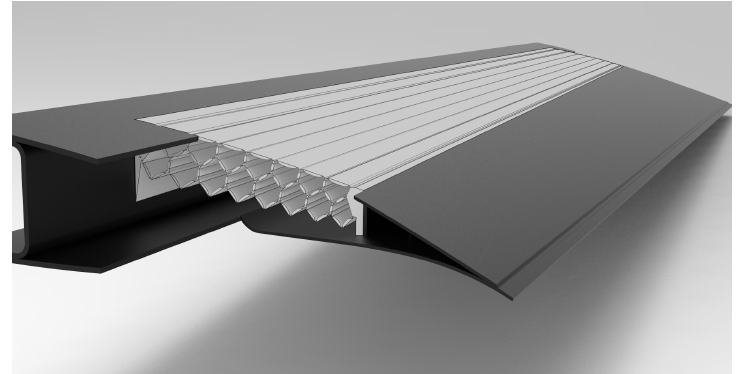
Figure 6. Design study of a morphing pressure-actuated cellular structure (PACS)